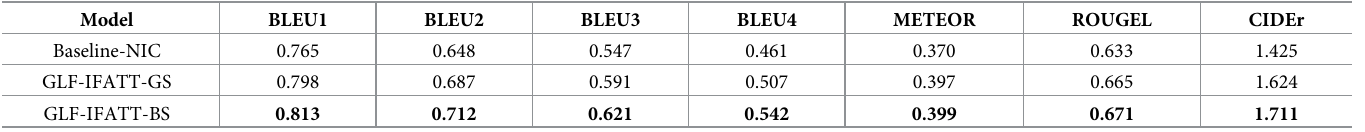
Table 4. Comparison of different search methods in this